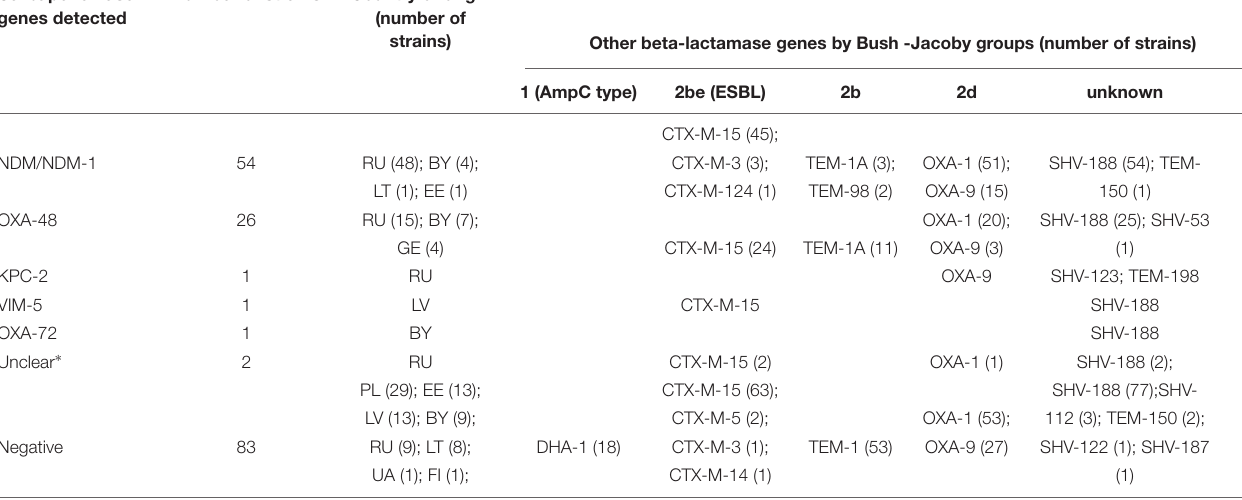
TABLE 3 | Presence of other beta-lactamase genes in screening positive strains arranged by carbapenemase groups and countries. Carbapenemase genes